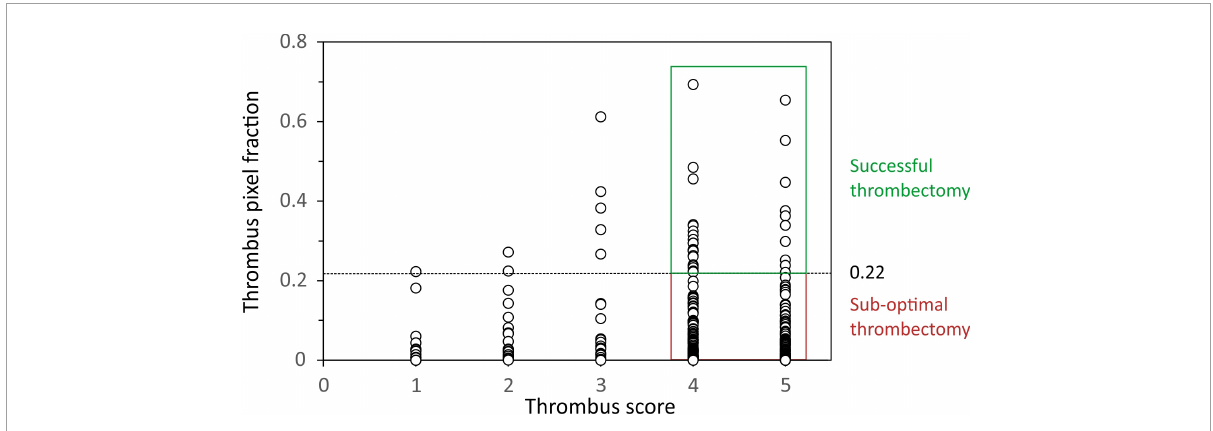
FIGURE2 Plot of the thrombus area within each spectral image (expressed as a fraction) against Thrombosis In Myocardial Infarction (TIMI) thrombus score. A threshold thrombus area fraction of 0.22 was used as the minimum value to define successful thrombectomy in patients with thrombus scores of 4 and